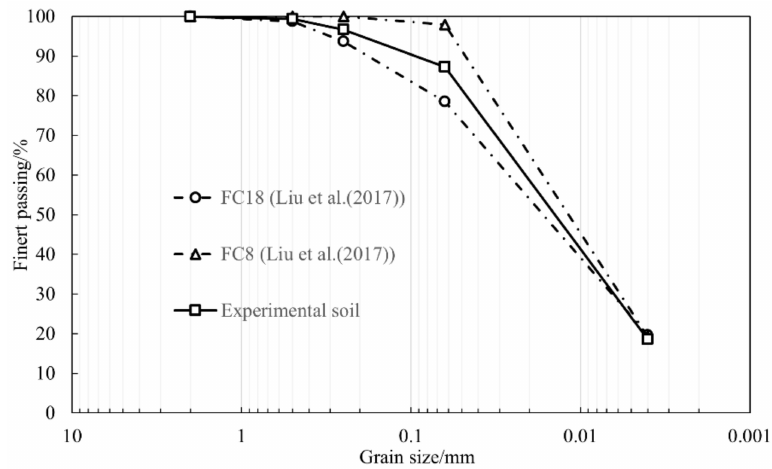
Figure 3. Comparison of the particle size distribution curve of soil sample and GMGS3